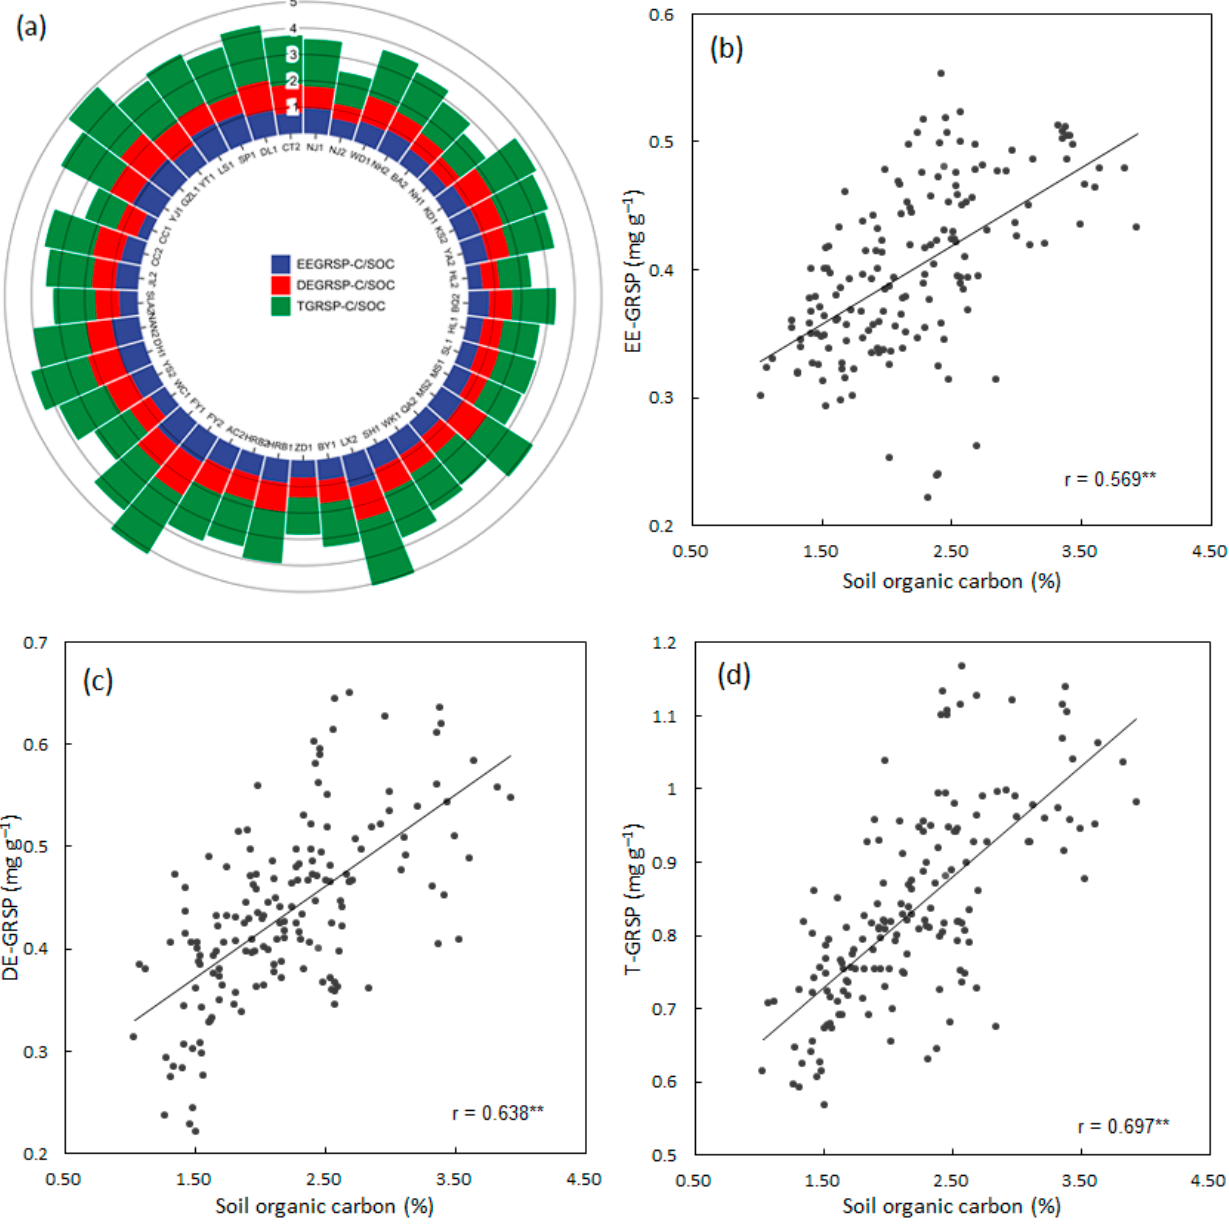
Figure 4. Contribution rate of GRSP to soil organic carbon ( a ) and relationship between GRSP and soil organic carbon ( b – d ) of the sampling sites. EE-GRSP, DE-GRSP, and T-GRSP represent easily extractable glomalin-related soil protein, difficult-to-extract GRSP, and total GRSP, respectively. ** p < 0.01.